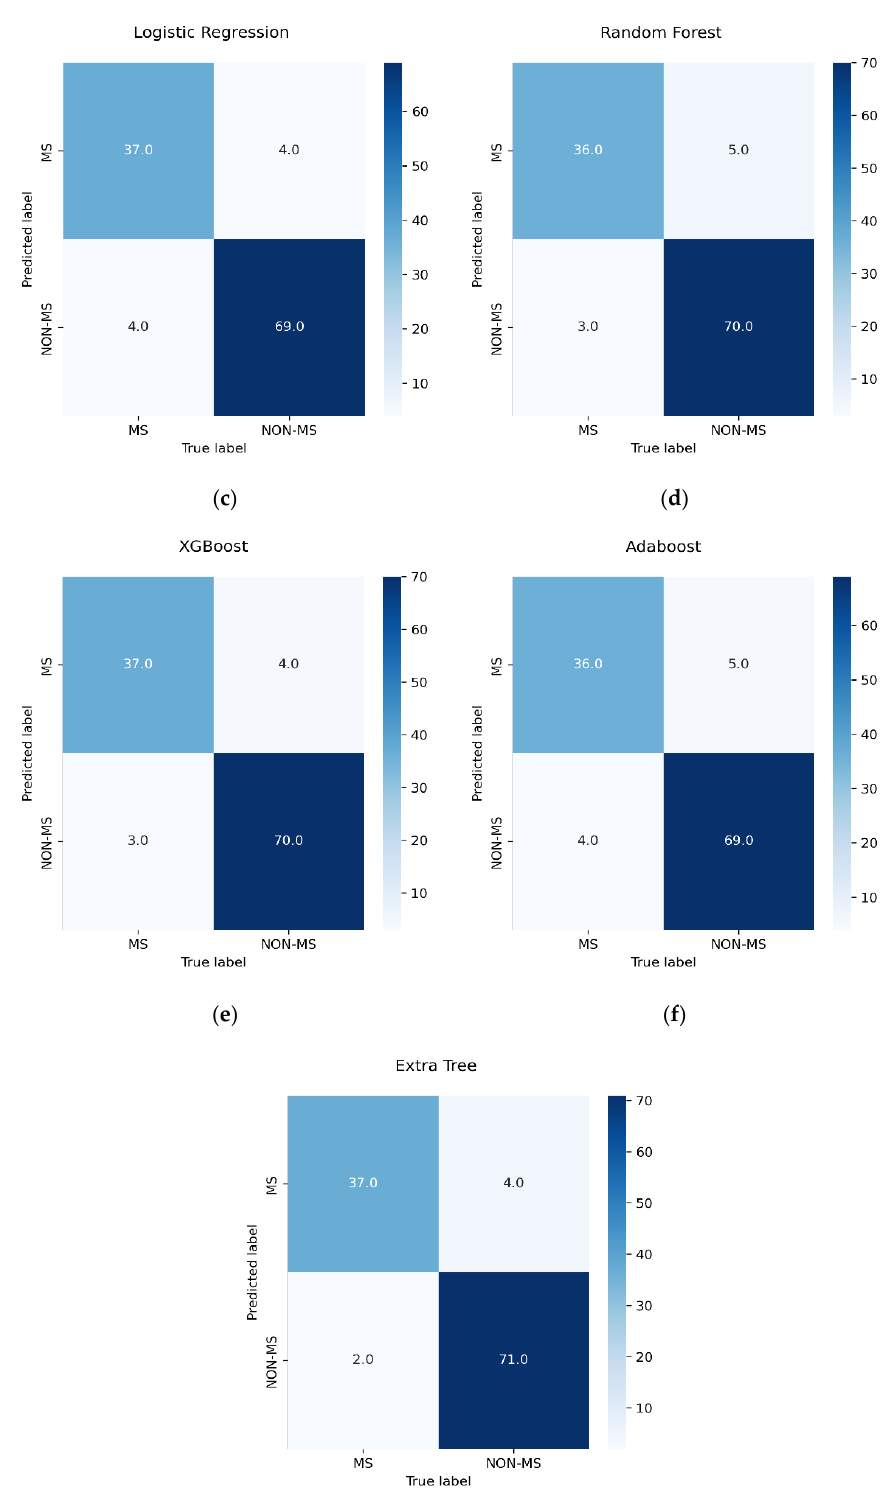
Figure 3. Confusion matrices: ( a ) SVM, ( b ) DT, ( c ) LR, ( d ) RF, ( e ) XGBoost, ( f ) AdaBoost, ( g )